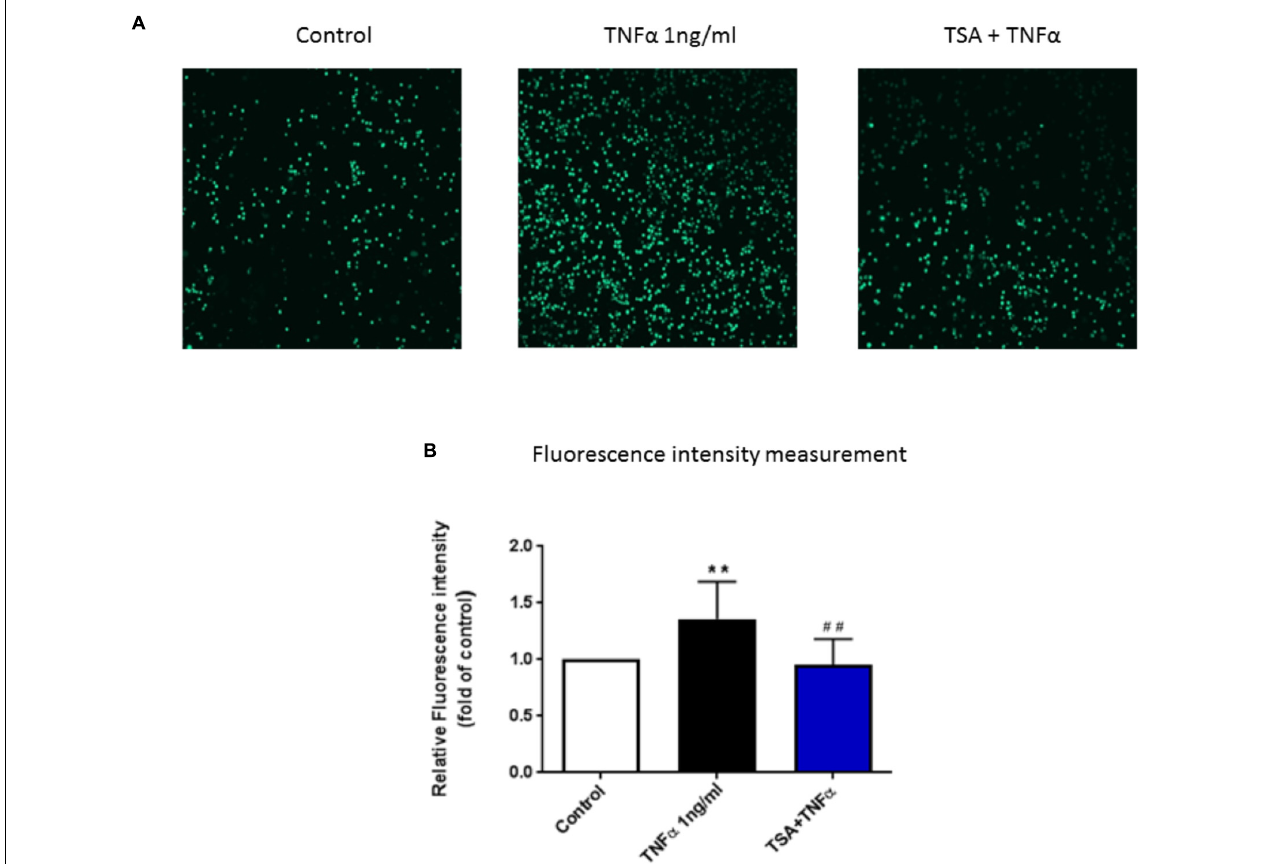
FIGURE 6 | The functional role of TSA on PBMC adhesion to HUVEC monolayer. Until HUVEC were confluent, cells were pre-treated with TSA (1 µ M) for 24 h, followed by 8 h TNF α stimulation, then co-cultured with calcein-AM labeled PBMC for 30 min. (A) Shows adhesive PBMC visualized by Yokogawa CV7000S imager; (B) shows the mean data of relative fluorescence intensity of adhesive PBMC presented as the fold of control. N = 8. ∗∗ p < 0.01 compared with control group; ## p < 0.01 compared with TNF α